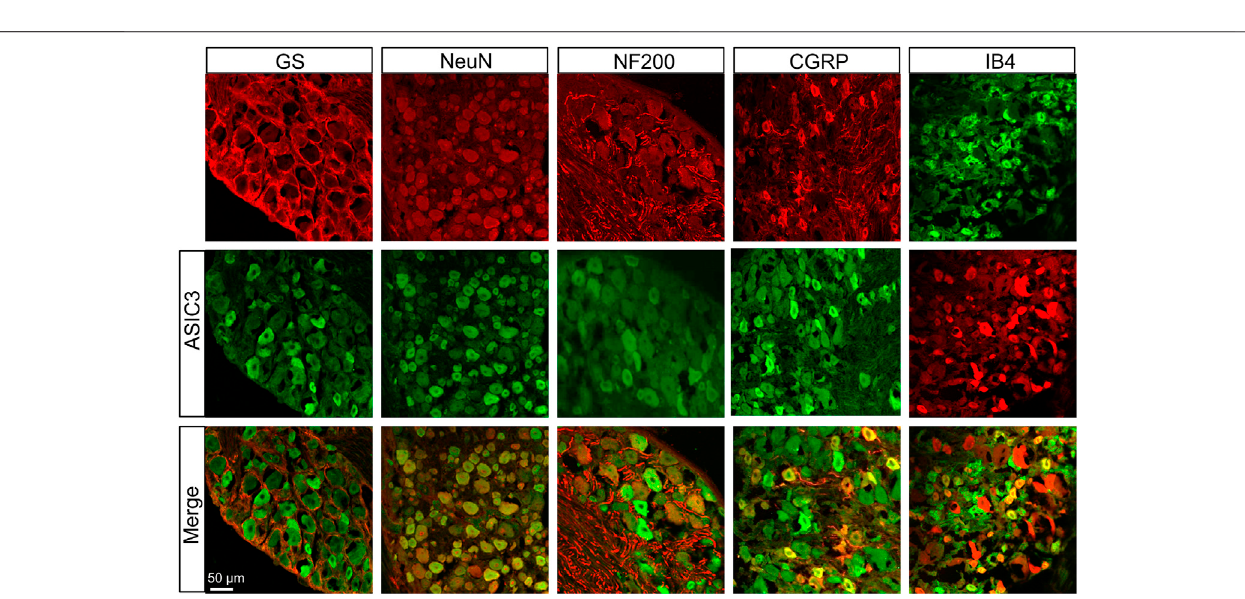
FIGURE3| Immuno fl uorescenceassayofASIC3inL4-6DRGs.ASIC3-positiveDRGcells(middlerow)wereco-labeledasneuron-positive(upperleftsecond,red) but not with GS-positive cells (upper left fi rst, red). ASIC3 was co-expressed in IB4-positive (upper right fi rst, green) and CGRP-positive (upper right second, red) DRG neurons. ASIC3 was a few expressed in NF-200-positive (upper middle, red) DRG neurons. Merges of ASIC3 with GS, NeuN, CGRP, NF-200, and IB4 are shown inthe lower row. Scale bar, 50 μ m. Quanti fi cation showing that ASIC3 was mainly located in small and medium sensory neurons labeled with IB4 and CGRP but a few with